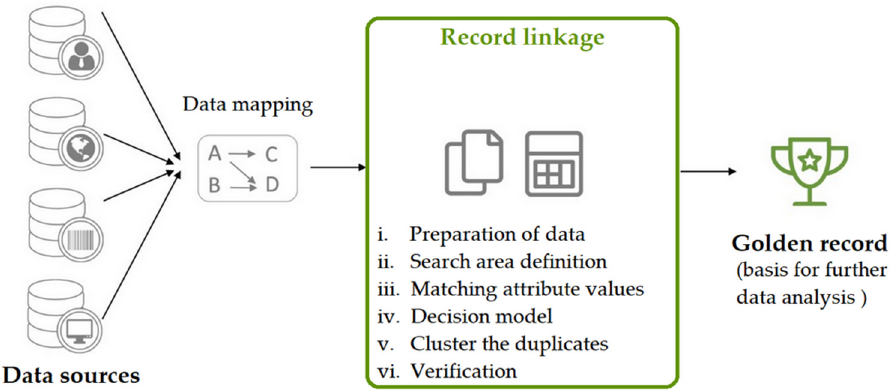
Figure 2. Framework for using Record